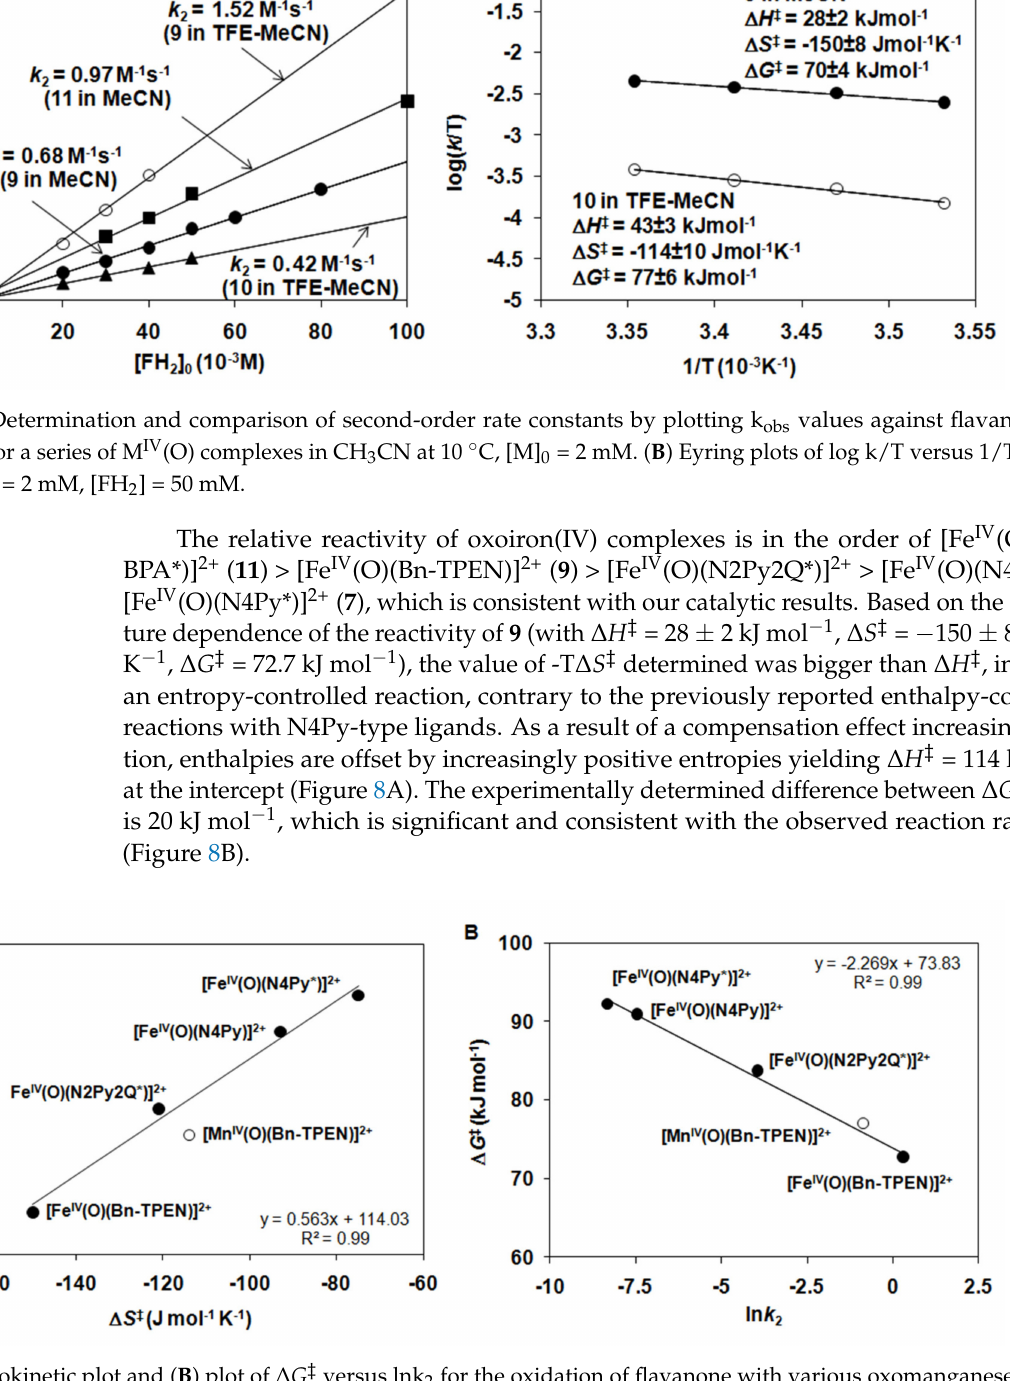
Figure 8. ( A ) Isokinetic plot and ( B ) plot of ∆ G ‡ versus lnk 2 for the oxidation of flavanone with various oxomanganese(IV) and oxoiron(IV)